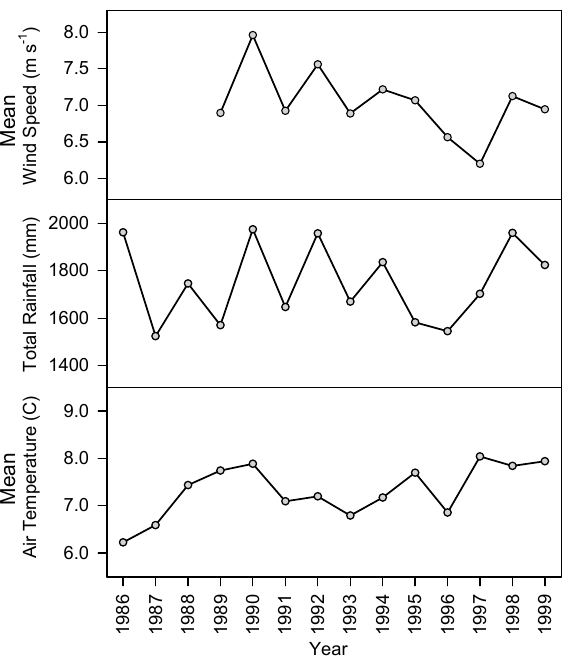
Figure 2. Annual mean wind speed (m s − 1 ) at the experiment site at Crookburn, Kershope, and total annual rainfall and mean air temperature at Eskdalemuir, for the duration of the tree growth periods. Eskdalemuir meteorological data supplied by the UK Met Office.